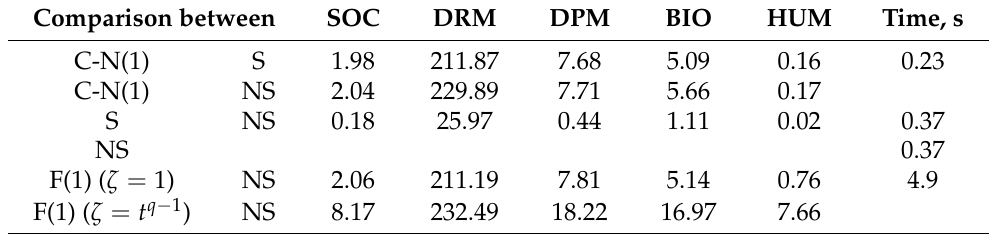
Table 4. Average absolute differences in percent of average indicator values and execution times, s, for integer- and fractional-order schemes. C-N(1)—Crank–Nicholson scheme; NS—non-standard scheme; S—standard scheme; F(1)—Crank–Nicholson scheme for the fractional-order model ( q = 0.98). Comparison